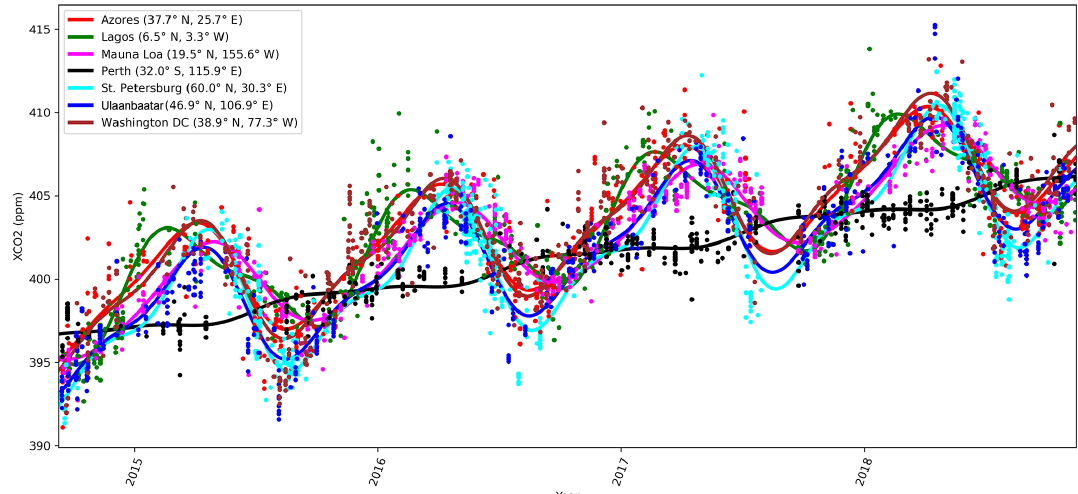
Figure 1. Mean function m with components f i given by Eq. (11). The solid lines show the mean function value for each day, fitted to the XCO 2 observations, marked by the dots. The OCO-2 mean function results are discussed in Sect.